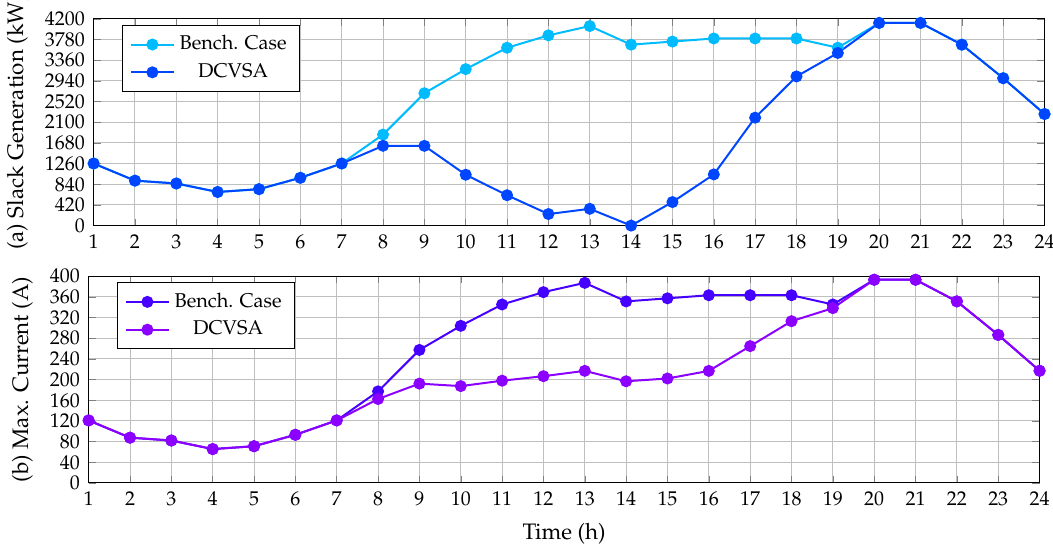
Figure 8. Impact of the PV inclusion in the IEEE 69-bus system: ( a ) power injections in the slack source, and ( b ) maximum current performance.